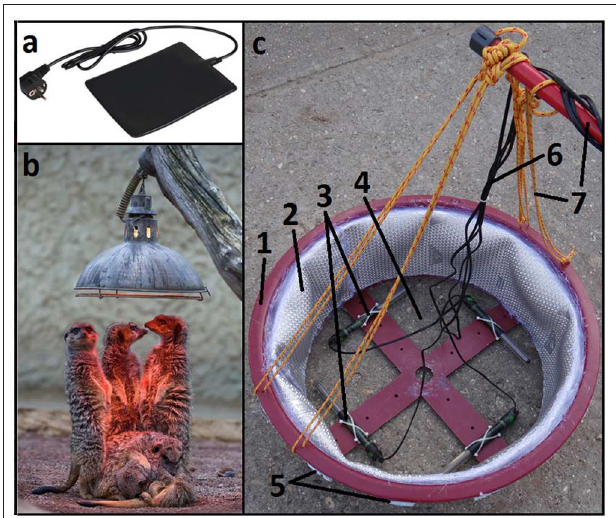
FIGURE 1 | Appliances that may be used for the realization of localized heating: (a) heat mat, (b) infrared heat lamp, as employed also for mammals in zoos (San Diego Zoo in this case), and (c) submersible heater [prototype: (1) skirting preventing heat dissipation via conductance; (2) insulation; (3) aquarium heaters fixed to bottom of appliance; (4) bottom with holes allowing amphibian larvae to enter warm spot; (5) swimmers under the upper edge stabilizing appliance and keeping it afloat; (6) electric cables; and (7) suspension facilitating in-pond placement of